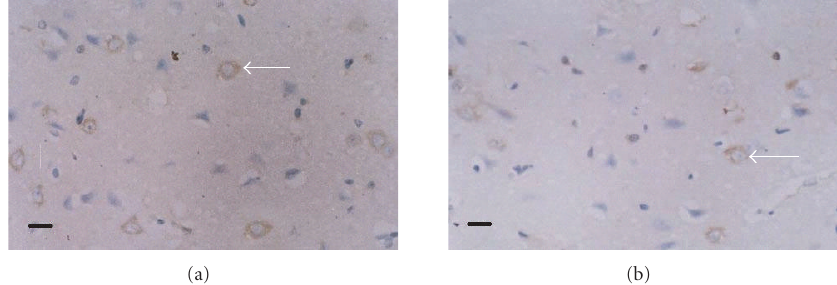
Figure 4: Immunohistochemical staining for COX-2 protein expression in (a) vehicle-treated rats and (b) theaflavin-treated rats (20mg/kg), SP × 400. The number of COX-2 immunoreactive positive cells in theaflavin group is significantly less than that of vehicle-treated group. Scale bar = 10 μ